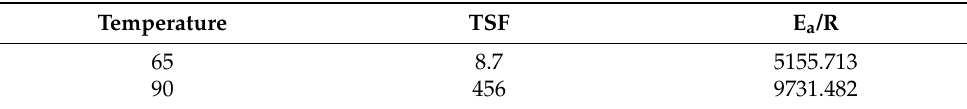
Table 7. Value of time-shift factor and activation